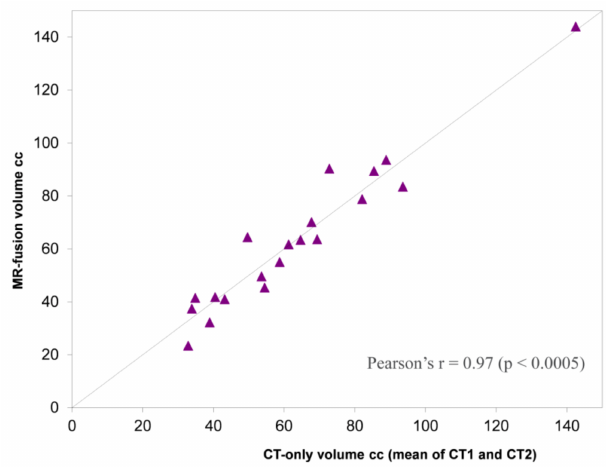
Figure 3. Plot of mean CT-only volume (CT1 and CT2) against MR-fusion volume. Dashed line: